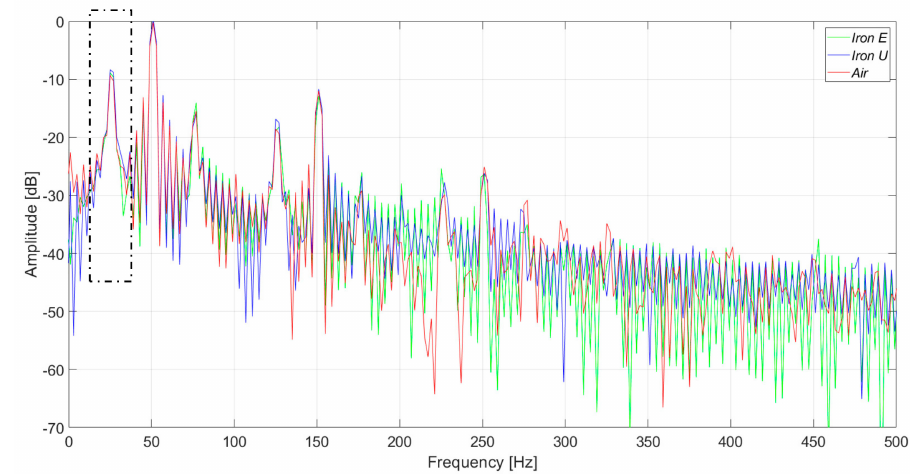
Figure 14. Frequency analysis of the induced voltage measurement with a 15% inter-turn rotor fault severity, in the upside position.